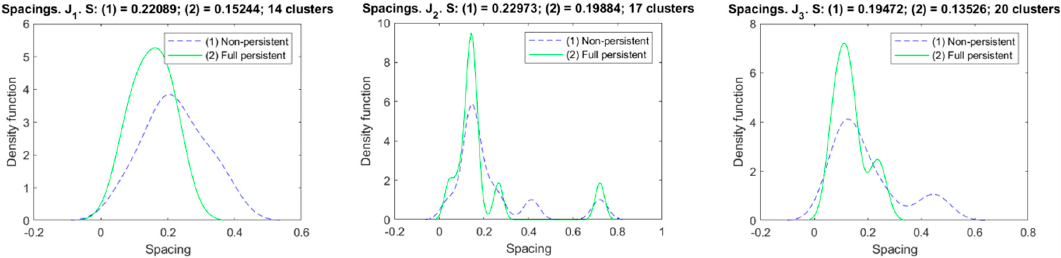
Figure 6. Statistical analysis of normal spacing of discontinuity sets extracted from the DSE.